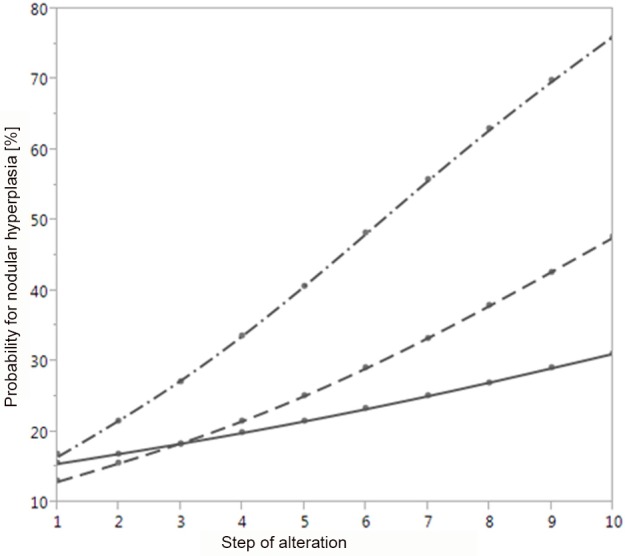
Probability of nodular hyperplasia of PG depending on values of individual risk-factors.Values of the duration of dialysis (−∙−∙−), PG volume measured by US (---) and serum levels of PTH (−−−) were categorized and standard units for a 10-step alteration were defined. The duration of dialysis was prolonged from 1 to 10 years by steps of 1 year. The PG volume determined by US was increased from 100 to 1.000 mm3 by steps of 100 mm3. The units of the 10-step alteration are given at the x-axis. The serum level of PTH was decreased from 1.000 to 100 pg/mL by steps of 100 pg/mL. While altering each parameter separately, the others were set to a default reference level with duration of dialysis = 2 years, PG volume determined by US = 400 mm3, and PTH serum level = 600 pg/mL. The calculated probability for nodular hyperplasia of PG is given in percent at the y-axis.